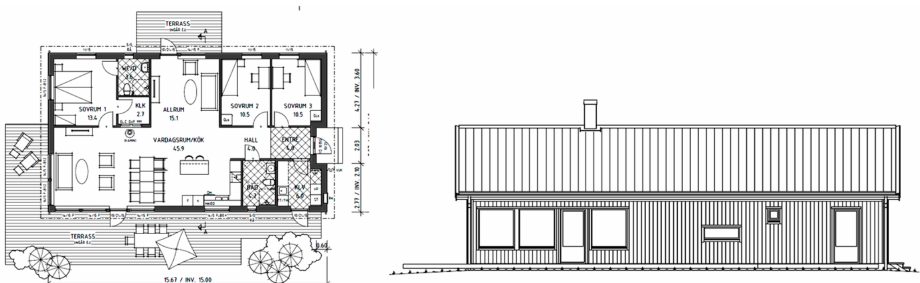
Figure 1. Ground floor plan and front facade of the studied